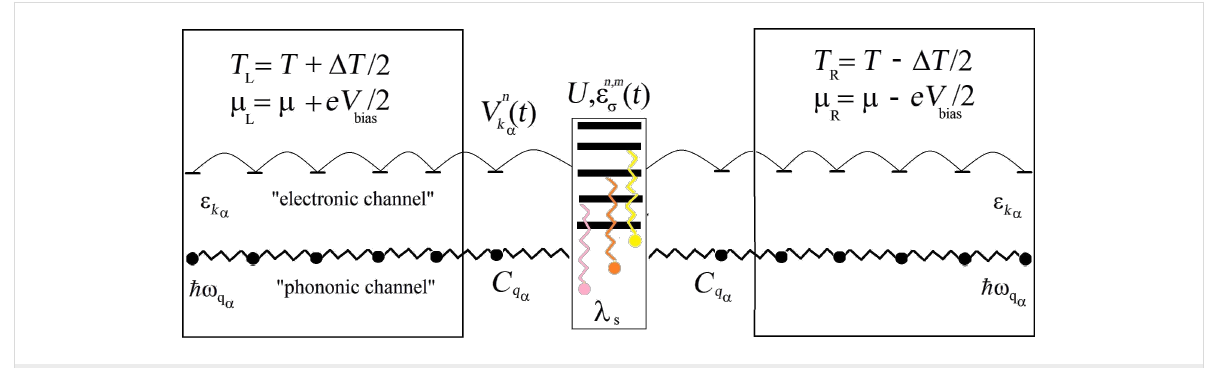
Figure 1: Scheme of the device studied in this work. The left lead (LL) and the right lead (RL) are kept at different chemical potentials μ L = μ + eV bias /2, μ R = μ − eV bias /2, and different temperatures T L = T + Δ T /2, T R = T − Δ T /2. The pumping signals are applied using the gates , while the back gate (Gate) induces a shift of V G to the quantum dot energy levels in the presence of a local Coulomb repulsion U and cou- pling λ s with N vibrational modes. The electronic channel in the leads is indicated by , while the phonon one by the energies